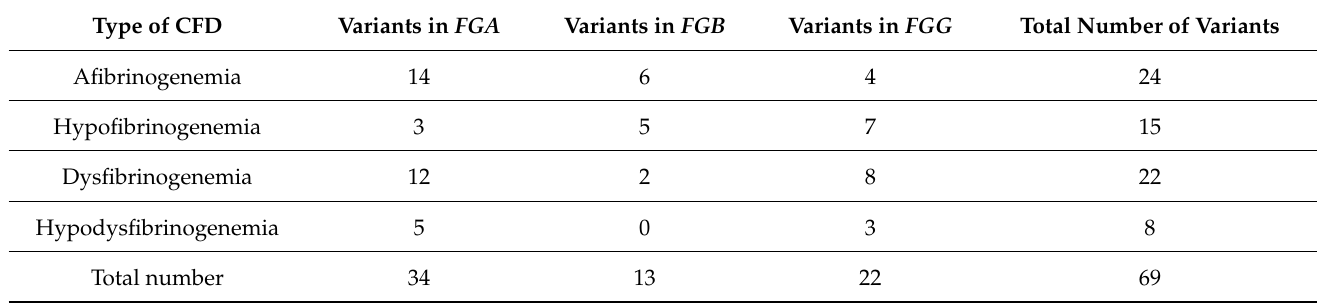
Table 1. Number of mutations in FGA , FGB , and FGG genes associated with both the bleeding and thrombotic phenotype summarized according to different CFD